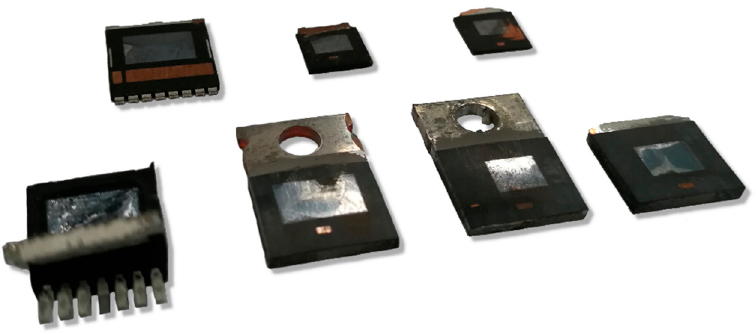
Figure 8. Opened switches from different manufacturers and with different electric parameters.